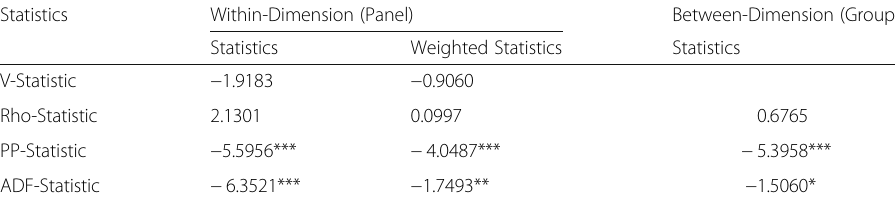
Table 6 Panel cointegration test (Pedroni) Statistics Within-Dimension (Panel) Between-Dimension (Group) Statistics Weighted Statistics Statistics V-Statistic